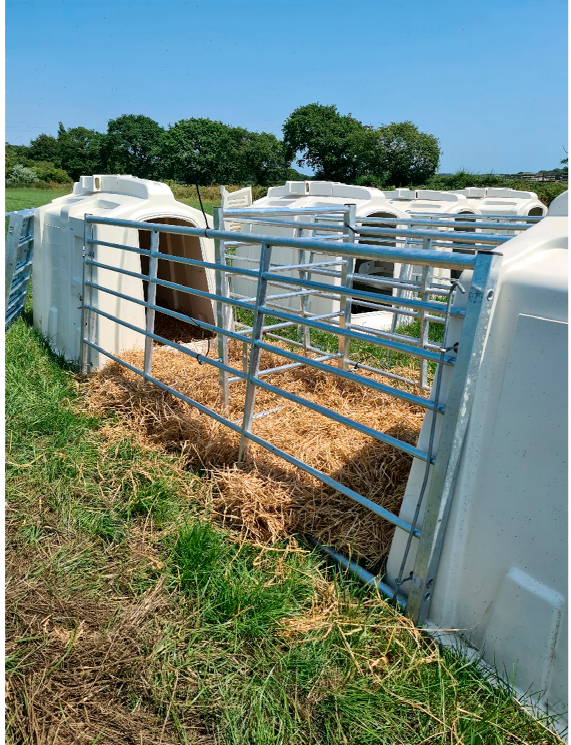
Figure 2. Image demonstrating the layout used for pair housing. For calves that were individually housed until three weeks of age (group c), a small partition gate was initially placed to separate the outdoor areas and create two pens. This was removed at three weeks of age. The calves housed in pairs from birth (group b) did not have the partition gate, therefore always had access to both hutches and the full outdoor